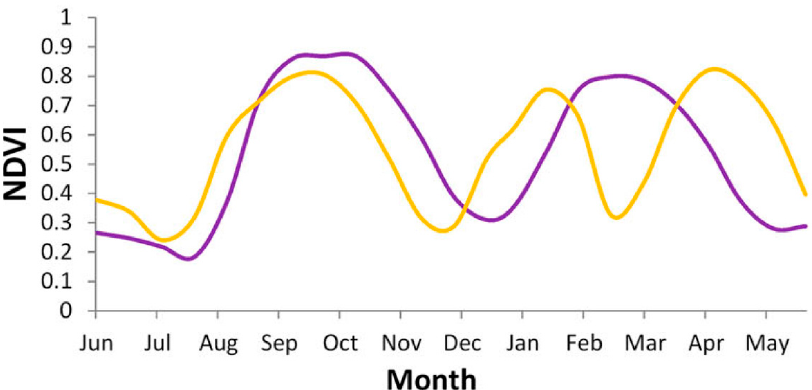
Figure 3. Example of the smoothed moderate-resolution imaging spectroradiometer (MODIS) Normalized Difference Vegetation Index (NDVI) time series profiles of sequential double-cropping and triple-cropping systems. These profiles show intensification practices adopted in South Asia that include growing two cycles of rice crop sequentially during the same growing season (purple line), and including a short growing cycle of grain legumes crops between the two rice cycles (orange line). Obtained from Gumma et al. [17].